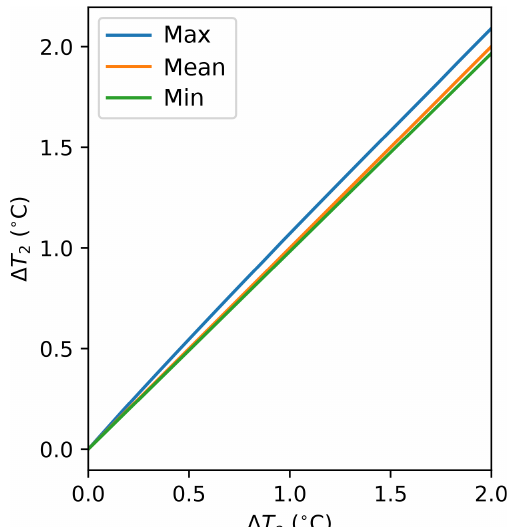
Figure 8. Impacts of Q F produced by an external simple anthro- pogenic heat model on the near-surface air temperature T 2 for 2 months: summer (July 2012, orange) and winter (December 2012, blue). Linear regression lines (dashed lines) show the overall